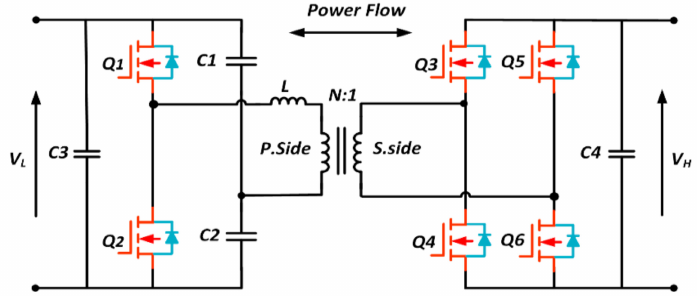
Figure 14. Isolated half-bridge–full-bridge bidirectional DC-DC converter